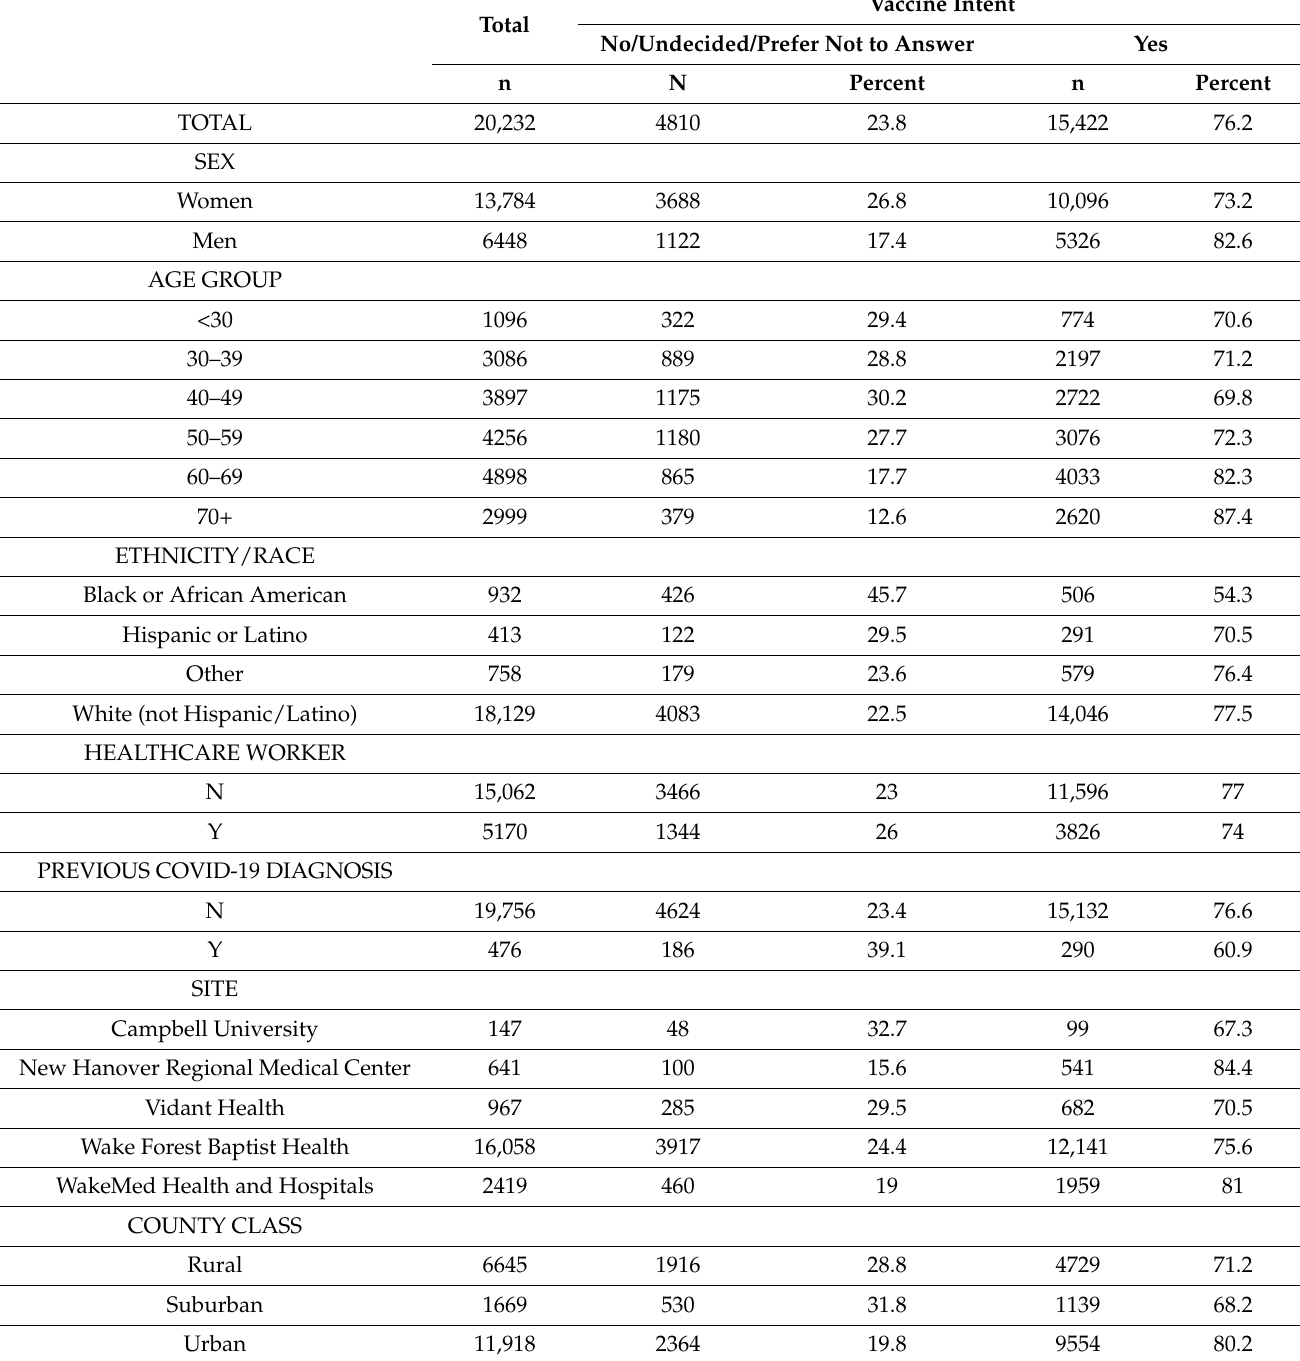
Table 3. Vaccine intent responses grouped by sex, age, race & ethnicity, healthcare worker status, previous COVID-19 diagnosis, Site and county class. n—no; P—prefer not to answer; N—no;